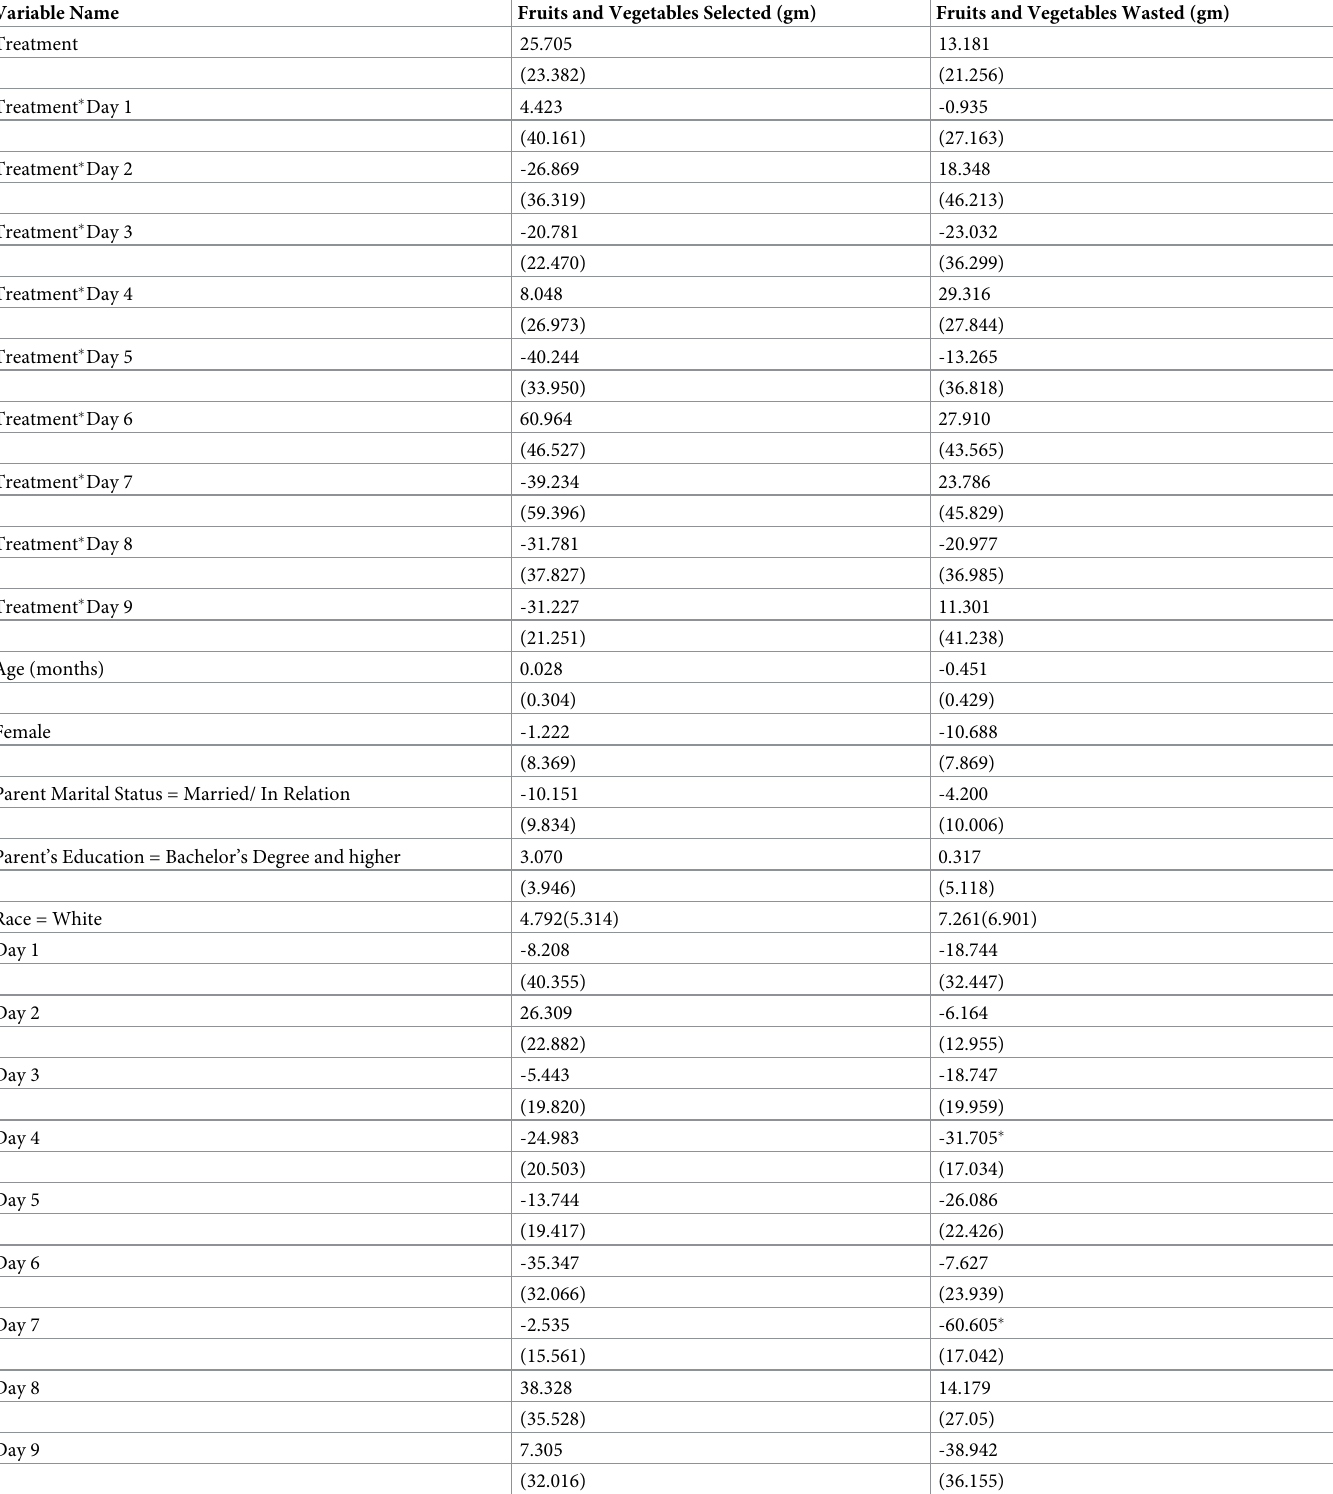
Table 6. Heterogeneity in the impact of nutrition education on the amount of fruits and vegetables selected and wasted through the intervention